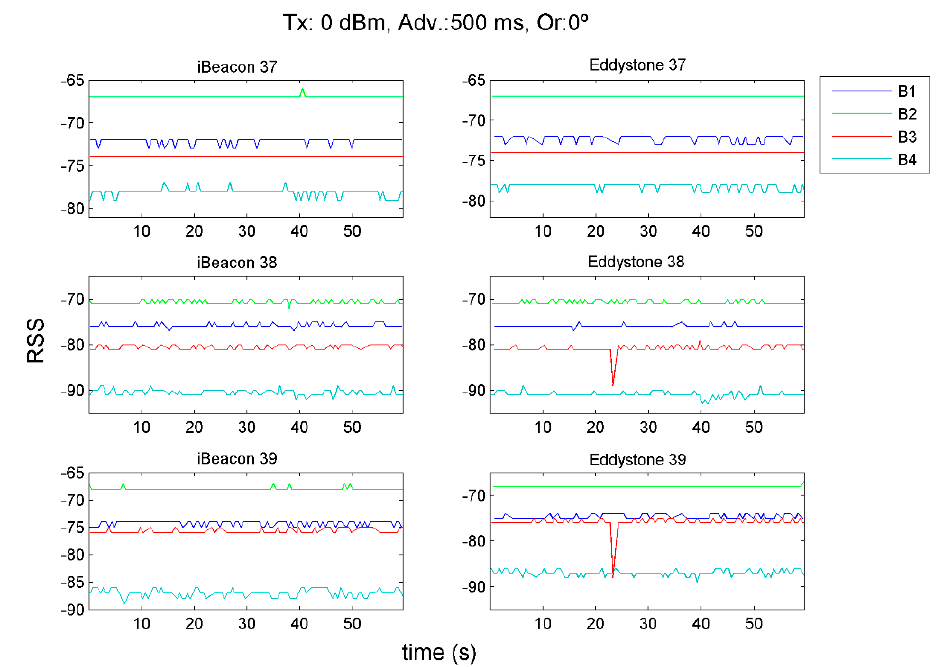
Figure 4. RSS vs. time graphs in an intermediate point of the grid, for all protocols and channels, all four beacons, setting the transmission power to 0 dBm, advertising interval to 500 ms and orientation 0° (equivalent to the cardinal direction